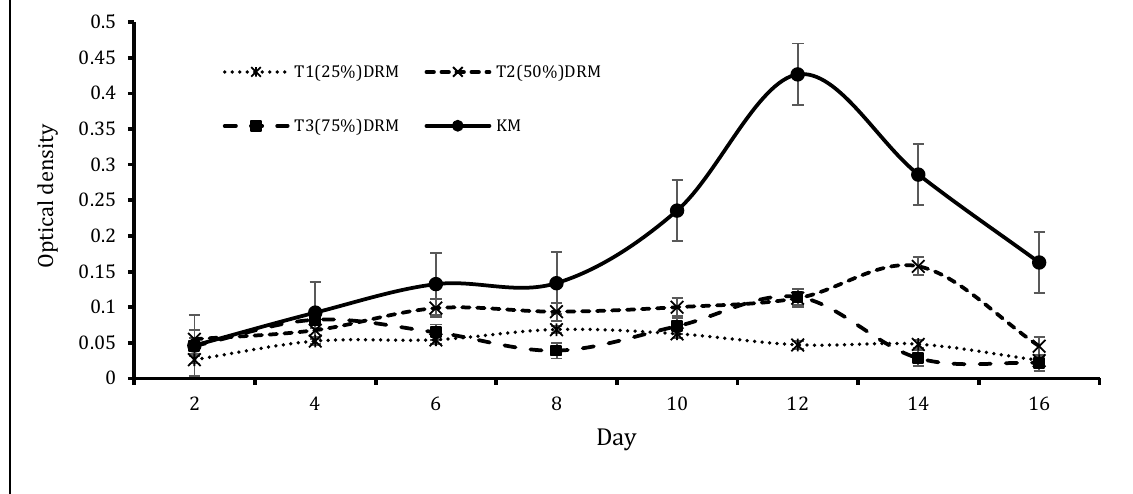
Figure 1: Mean values of optical density of media contained S. platensis in the supernatant of three different digested rotten mangoes, and KM. Vertical bars represent standard errors. Optical density (OD) of media containing spirulina was found to increase up to the 14th day of the culture of all the media of DRMM and KM and then decreased up to the 12th day of the experiment (Figure 1). However, the OD of 25% DRMM contained spirulina was 0.068±0.002 g/L, whereas the highest OD of 50% DRMM contained spirulina was found 0.157±0.005 g/L (Figure 1). The OD of supernatant of 75% DRMM contained spirulina